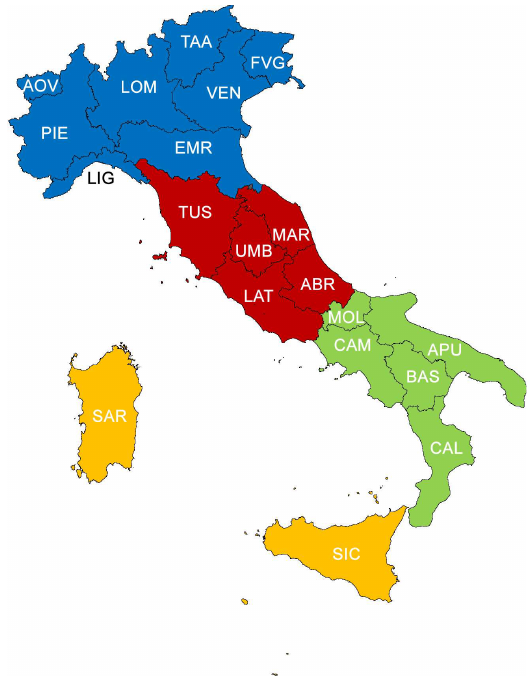
Figure 1. Division of Italy into sectors (North—blue, Centre—red, South—green, major islands— orange). Abbreviations of the administrative regions: AOV = Aosta Valley, PIE = Piedmont, LOM = Lombardy, TAA = Trentino-Alto Adige, VEN = Veneto, FVG = Friuli-Venezia Giulia, LIG = Liguria, EMR = Emilia Romagna, TUS = Tuscany, UMB = Umbria, MAR = Marche, ABR = Abruzzi, LAT = Latium, CAM = Campania, MOL = Molise, APU = Apulia, BAS = Basilicata, CAL = Calabria, SIC = Sicily, SAR =